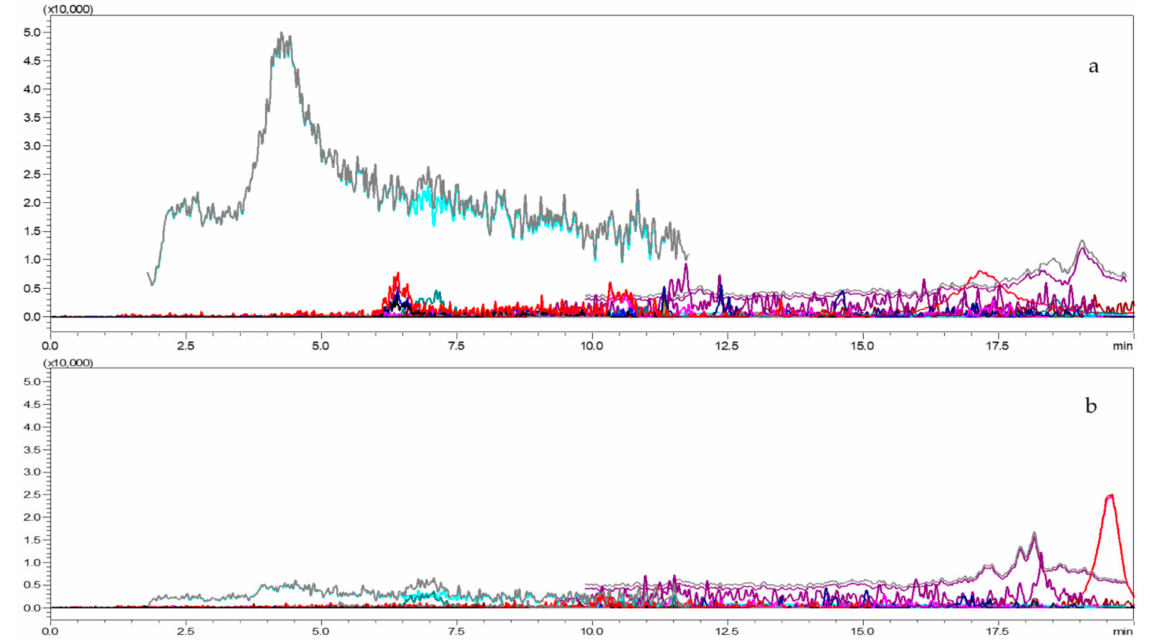
Figure 4. LC-MS/MS chromatograms for blank tomato ( a ) and Capsicum matrix ( b